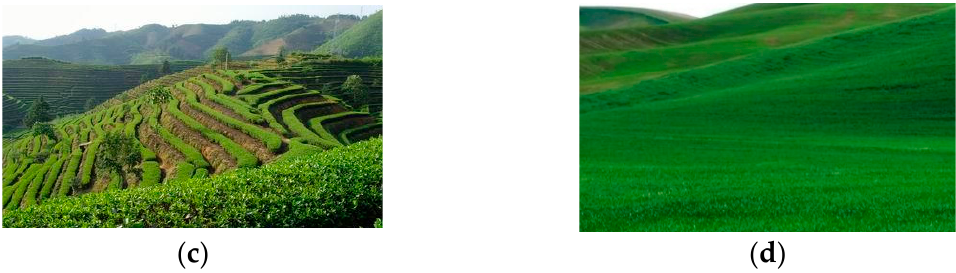
Figure 3. Typical spatial forms of collective lands: privately farmed plots of cropland ( a , b ); privately farmed plots of hilly land ( c , d ).